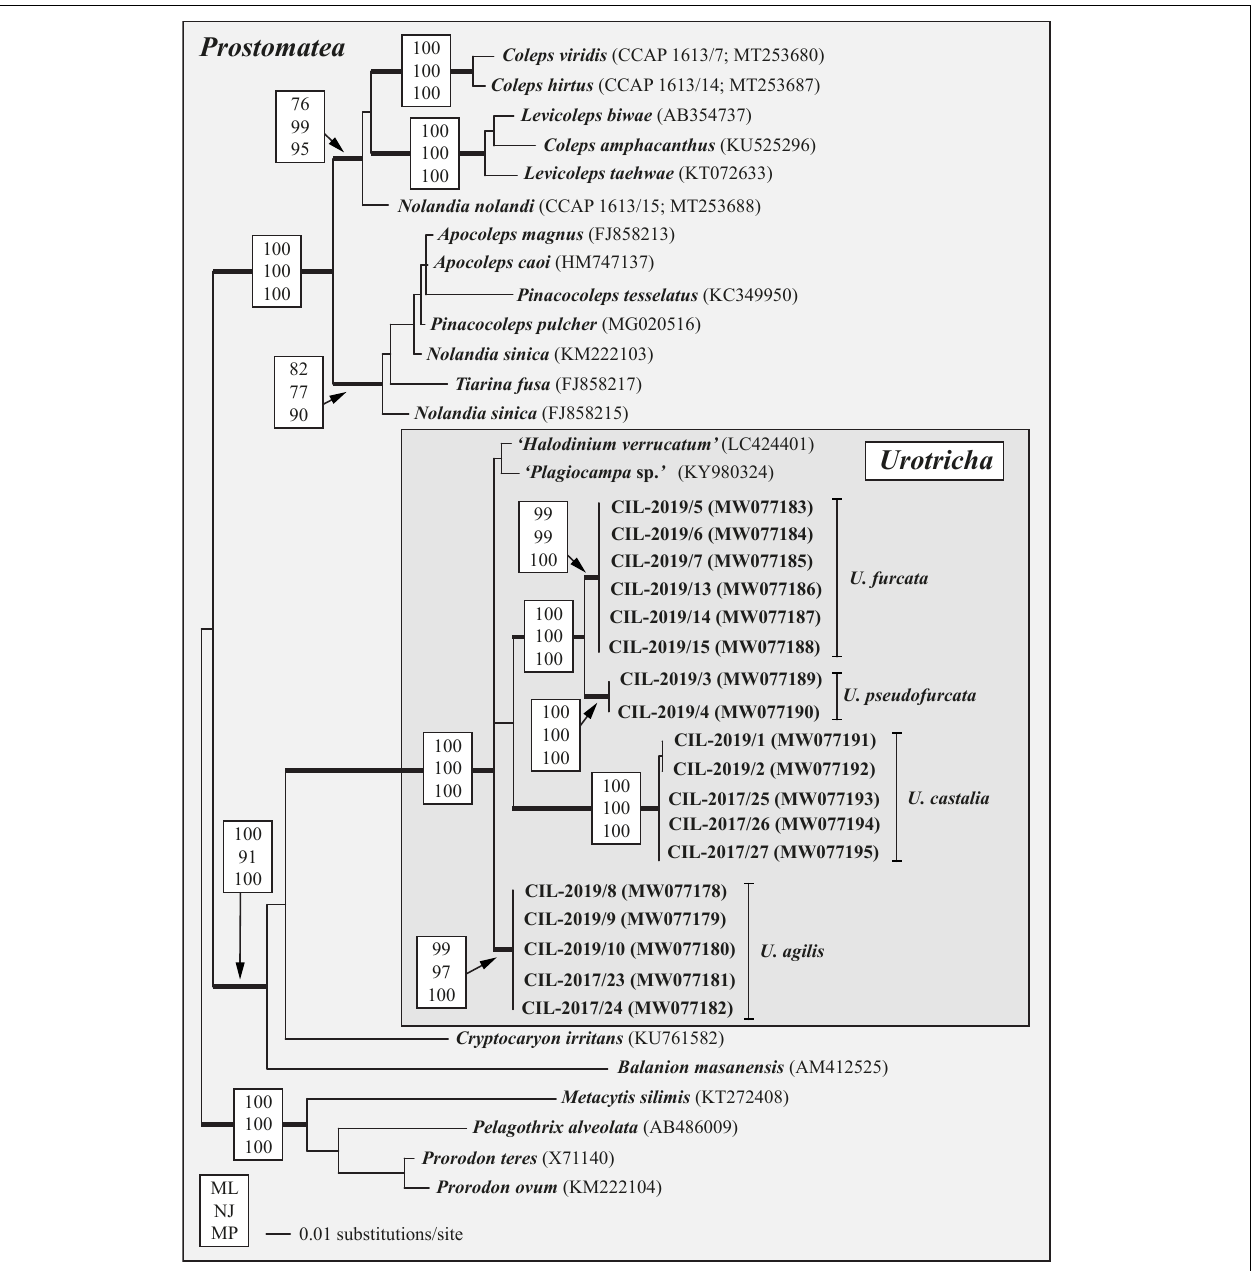
FIGURE 6 | SSU rDNA phylogeny of 35 prostomatean taxa inferred from 1,755 aligned positions of the sequences analyzed by maximum likelihood, neighbor joining, and maximum parsimony methods in PAUP 4.0a167. Best model was GTR + I + (cid:48) model (base frequencies: A 0.2777, C 0.1830, G 0.2486, U 0.2906; rate matrix: A-C 1.3273, A-G 2.7354, A-U 1.5527, C-G 0.2974, C-U 4.7063, G-U 1.0000) with the proportion of invariable sites ( I = 0.6584) and gamma distribution shape parameter ( (cid:48) = 0.6289) as calculated with the automated model selection tool implemented in PAUP. The branches in bold are highly supported in all bootstrap analyses (bootstrap values > 50% calculated with PAUP, using the maximum likelihood, neighbor joining, and maximum parsimony). The GenBank accession numbers in brackets follow the species names. The accession numbers in bold indicate strains investigated in this